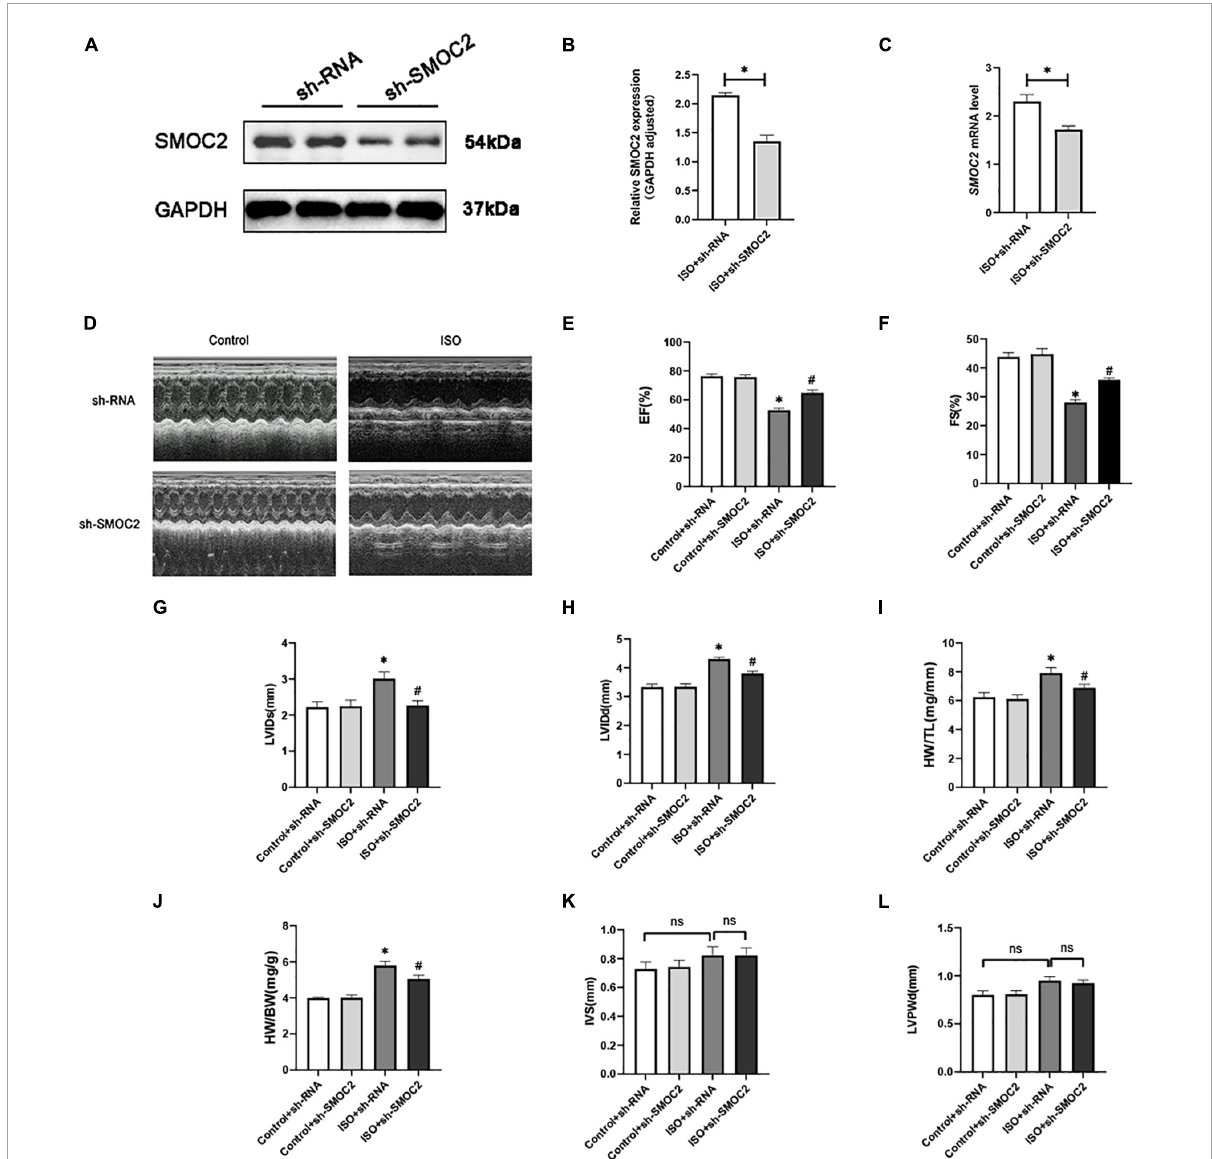
FIGURE2 SMOC2 knockdown partially reversed the myocardial function loss. (A,B) SMOC2 expression after sh-RNA or sh-SMOC2 injection in mice heart ( n = 6). (C) mRNA levels of SMOC2 after sh-RNA or sh-SMOC2 injection in mice heart ( n = 6). (D) Representative images of echocardiographic measurement of cardiac function in mice. (E–L) Echocardiographic measurements of ejection fraction (EF), fractional shortening (FS), left ventricular internal diameter at end-systole (LVIDs), left ventricular internal diameter at end-diastole (LVIDd), HW/TL, HW/BW, interventricular septal thickness at diastole (IVS), and left ventricular posterior wall thickness at diastole ( n = 8). ∗ p < 0.05 vs. the control + sh-RNA group. # p < 0.05 vs. the ISO + sh-RNA group. n.s.,